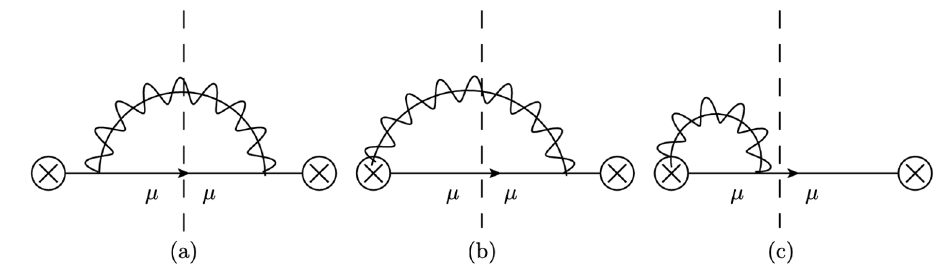
Figure 3 . Feynman diagrams for the semi-inclusive jet function at one loop. The dotted lines denote the cut. Mirror images for (b) and (c) are omitted. For the muon semi-inclusive jet functions, the fermions cut by the dotted lines are